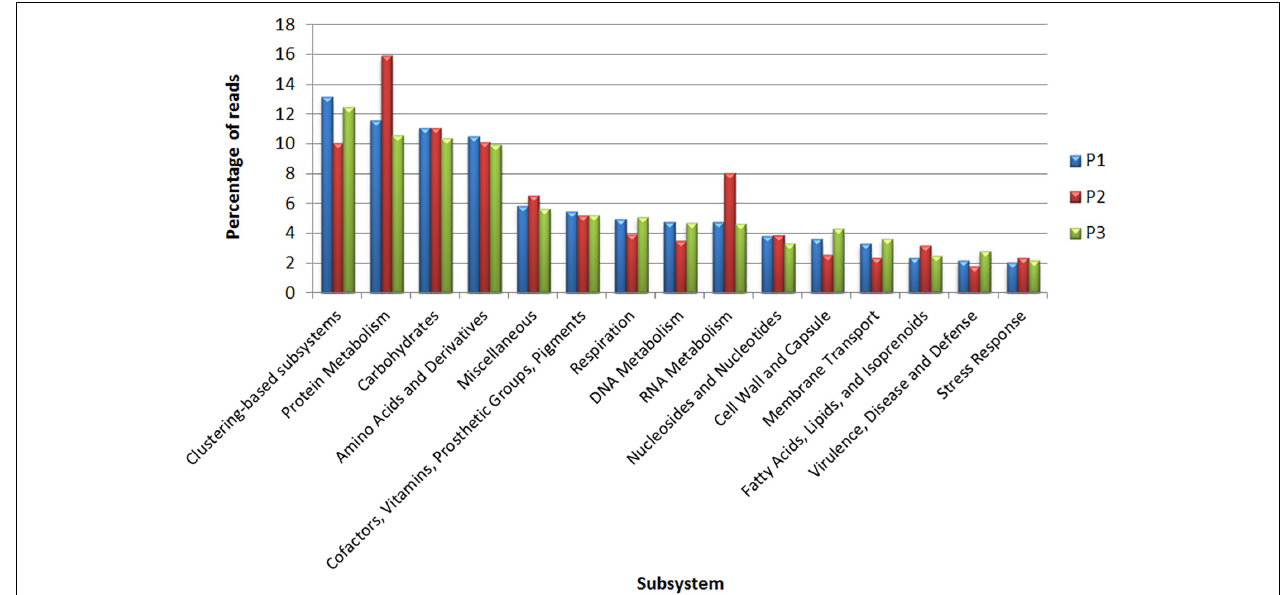
FIGURE 4 | Classification of metagenomic data obtained from sites P1, P2, and P3 in subsystems according to MG-RAST.